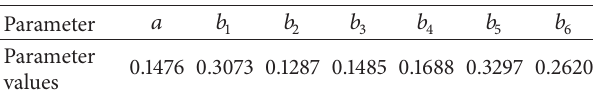
Table 5: Neural network parameter results of the optimization of the quantum genetic